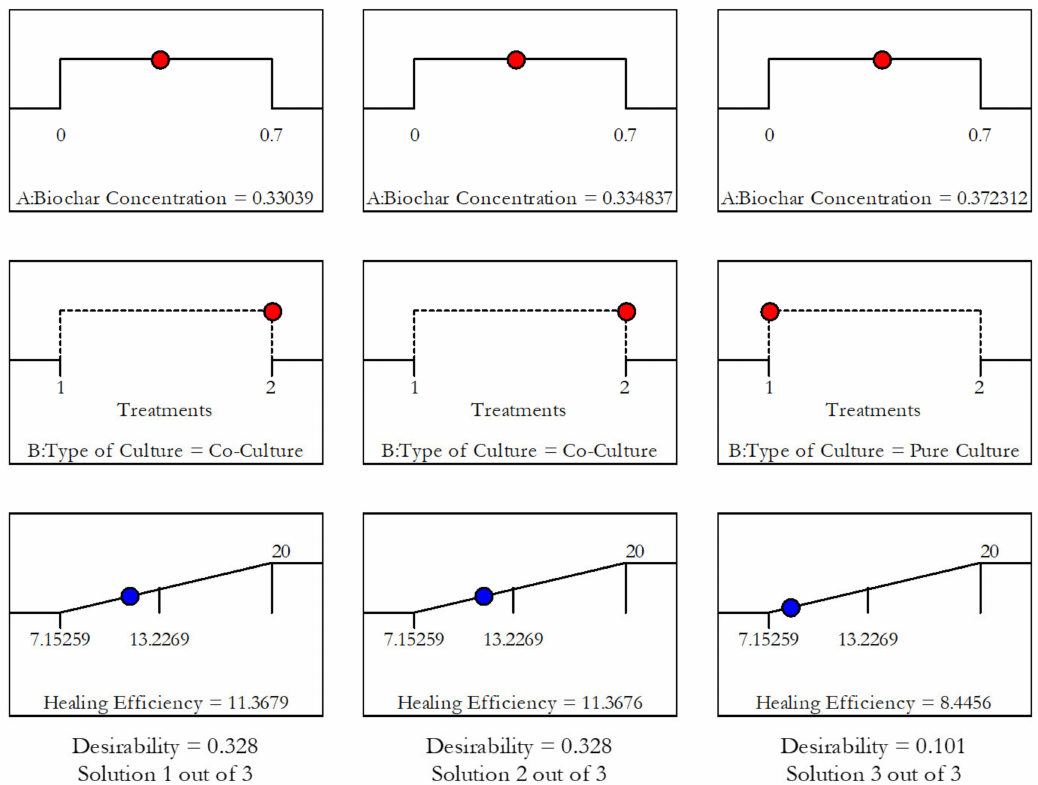
Figure 6. Solutions for optimal healing e ffi